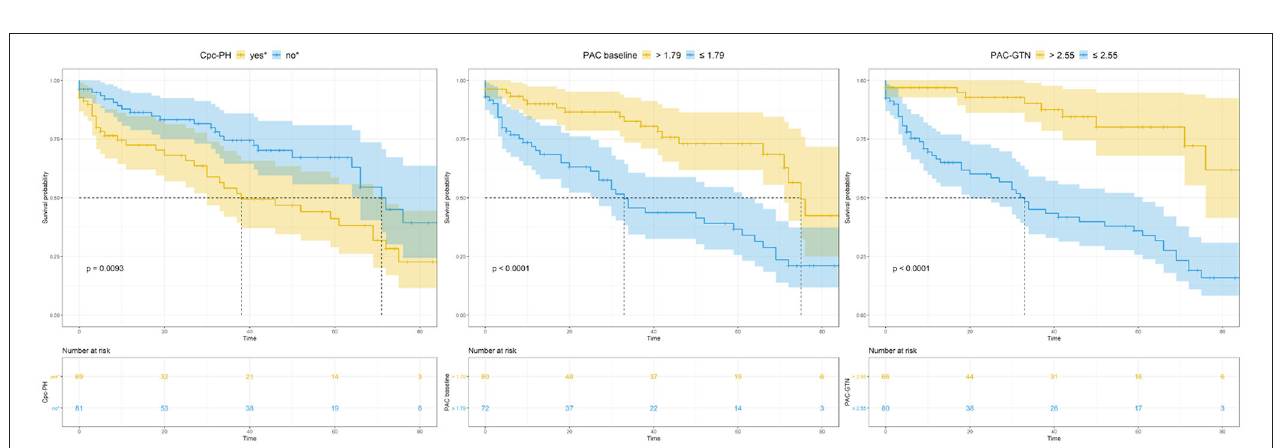
FIGURE 4 | Kaplan-Meier analysis of key variables CpcPH, baseline PAC, and PAC-GTN. CpcPH, combined post- and pre-capillary pulmonary hypertension (“yes,” if pulmonary vascular resistance > 3 wood units and/or diastolic pulmonary gradient ≥ 7 mmHg); PAC, pulmonary arterial compliance; GTN, glyceryl